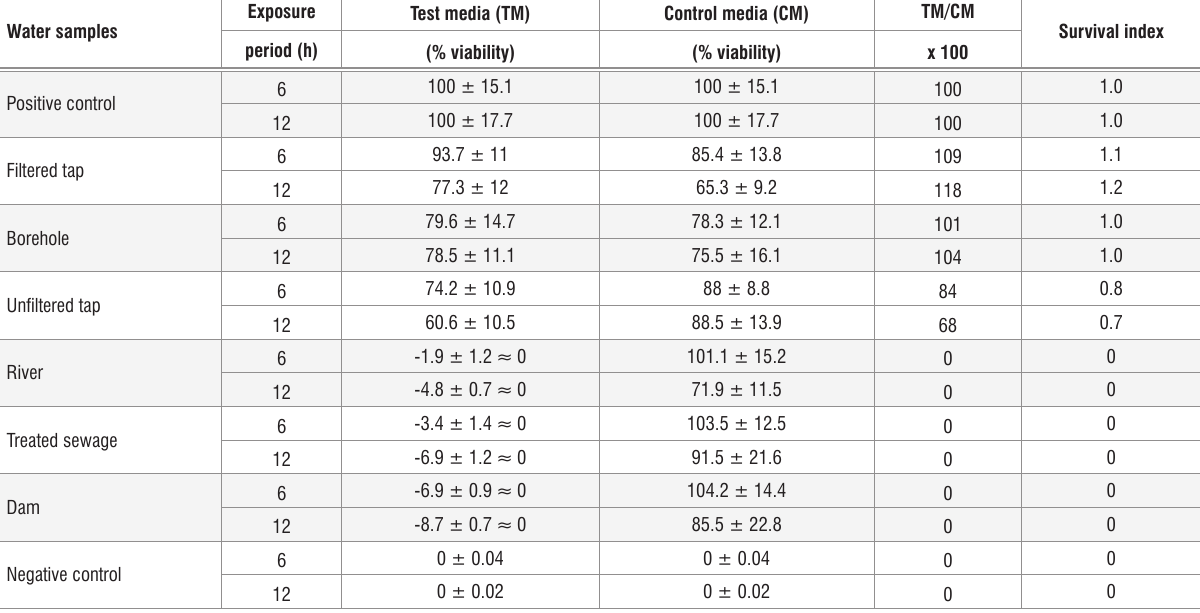
Table 1: Cell viability after exposure to different water samples (test media) and corresponding control media Exposure Water samples